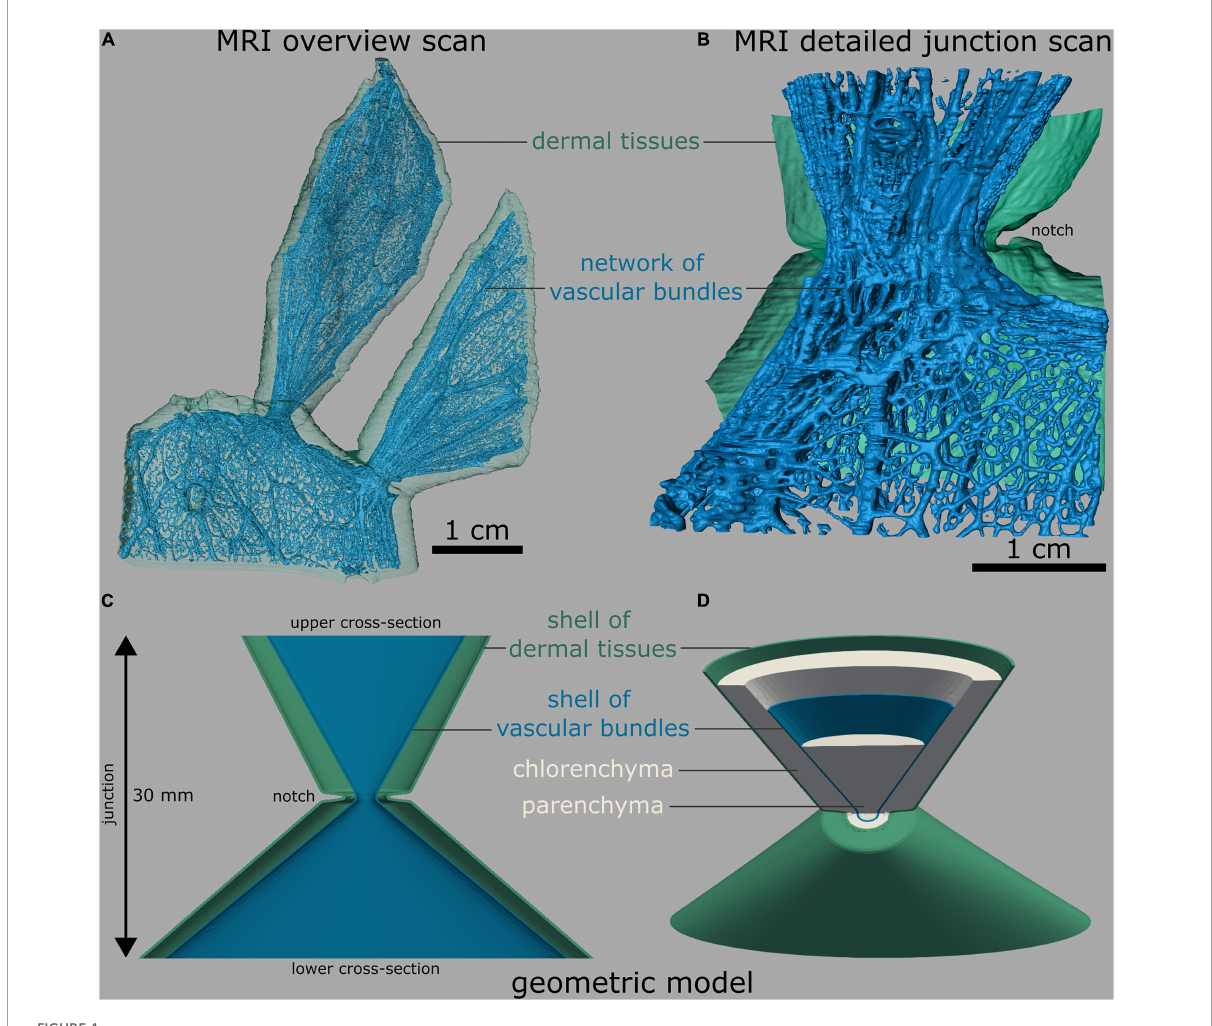
FIGURE4 Branch-branch junctions of O. ficus-indica . (A,B) Segmented magnetic resonance imaging scans (adapted from Mylo et al., 2021a). (C,D) Finite element mesh. (A) Overview scan with one sublateral branch and two connected lateral branches. The net-like arrangement of the vascular bundles is visible. (B) Detailed image of a branch-branch junction with a bisected layer of dermal tissues (consisting of the epidermis, hypodermis, and, in older branches of the periderm) for better visibility. (C) Bisected front view and (D) tilted view with bisected upper half of the “standardized geometric model,” consisting of five shells, namely, an outer shell of dermal tissues (green), a chlorenchyma shell (gray), a vascular bundle shell (blue), and a central parenchyma core (gray). For better illustration, all the shells are shown only in (D)